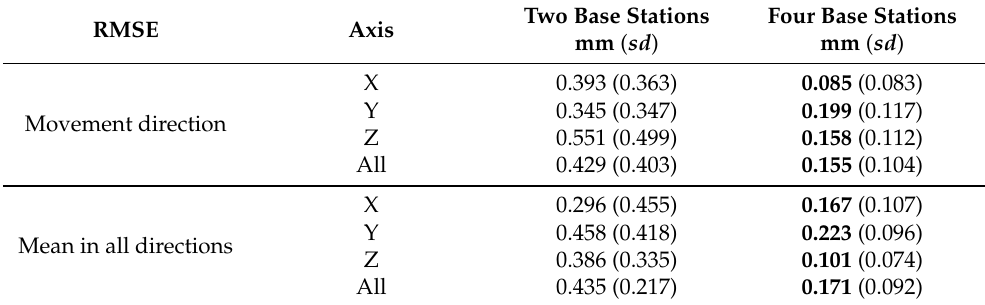
Table 2. Errors (mm) in tracking of translation with standard deviations ( sd ), five measurement runs for each movement, and the best results are